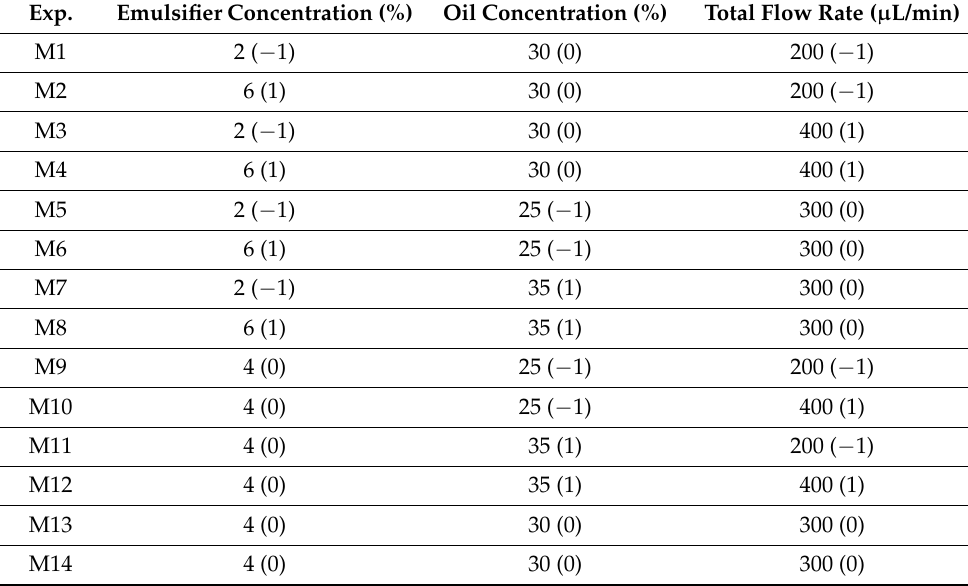
Table 2. Experimental plan for the preparation of emulsions in the microfluidic system.